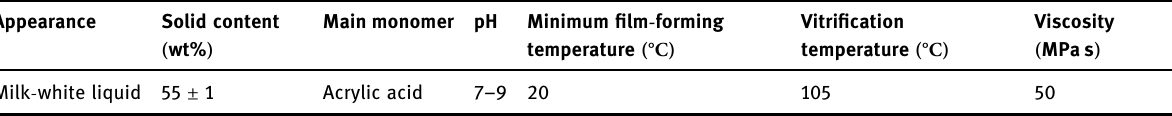
Table 2: Main physicochemical properties of polyacrylate latex